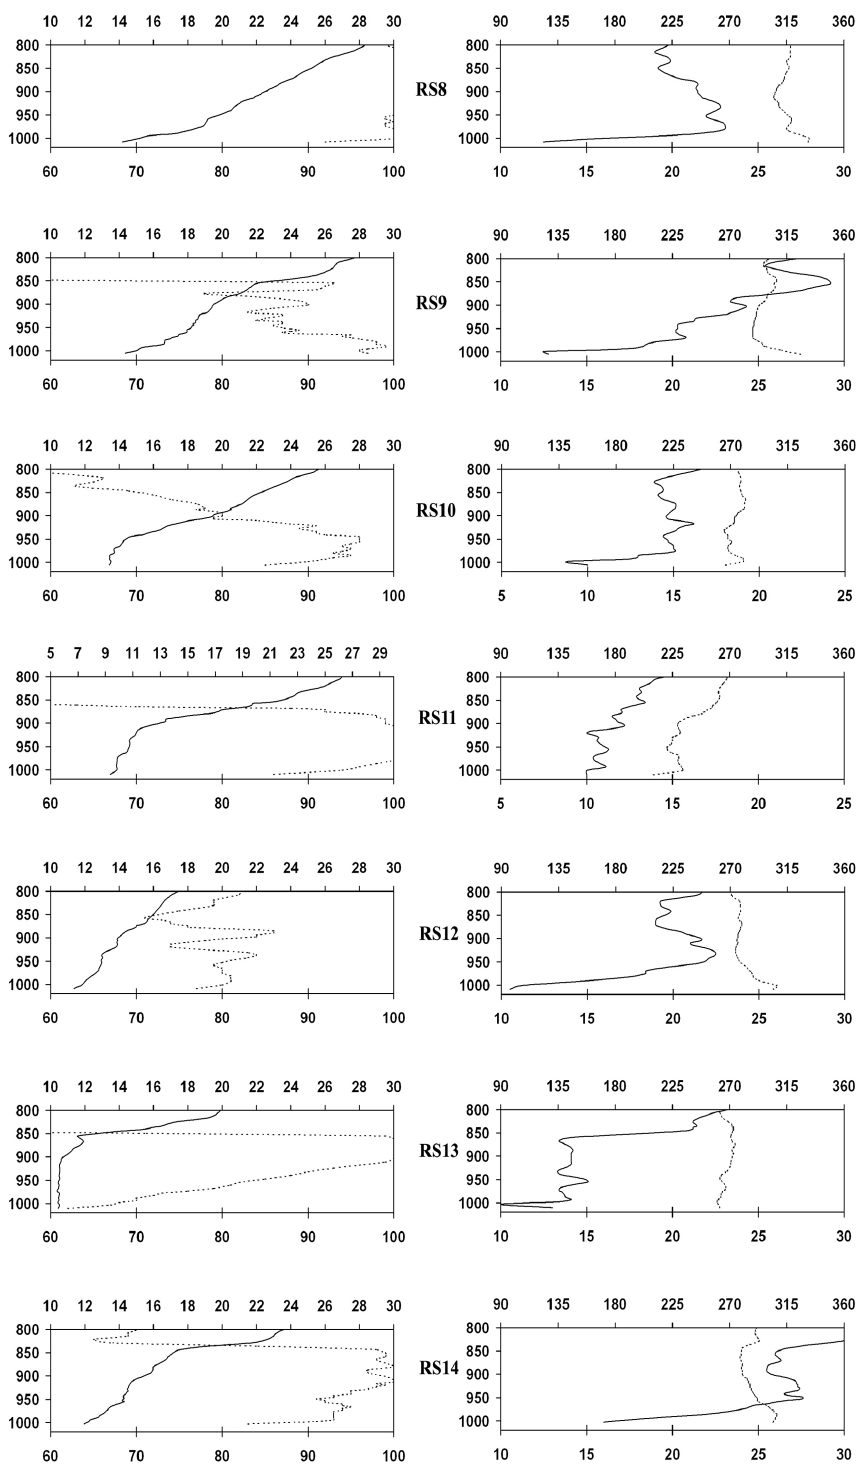
Fig. 7. Left column: Vertical profile of potential temperature in ◦ C (bold line – upper horizontal axis) and relative humidity in % (dashed line – lower horizontal axis) for the rs8 to rs14 radiosondes. Right column: Vertical profile of wind speed in ms − 1 (bold line – lower horizontal axis) and wind direction in deg (dashed line – upper horizontal axis) for the rs8 to rs14 radiosondes. For locations, dates and times